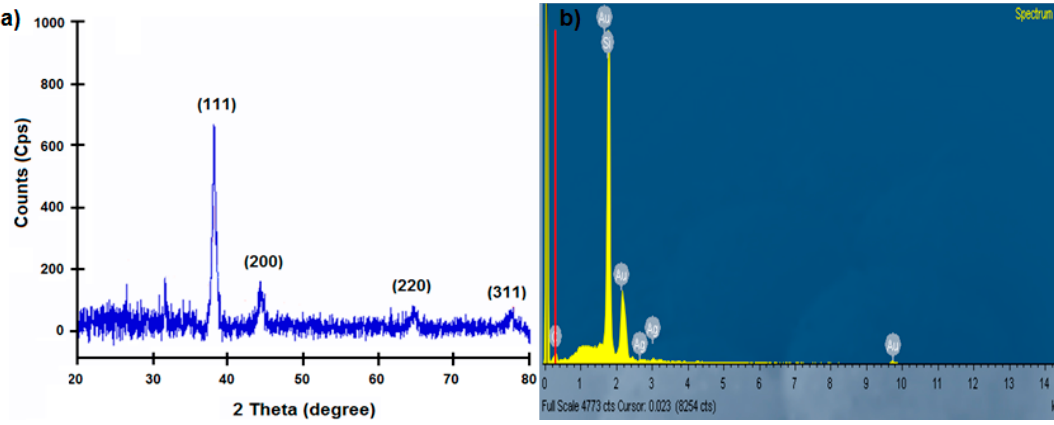
Figure 5. ( a ) X-ray diffraction (XRD) spectra of AuNRs, ( b ) Energy-dispersive X-ray (EDX) spectra of AuNR-coated glass.